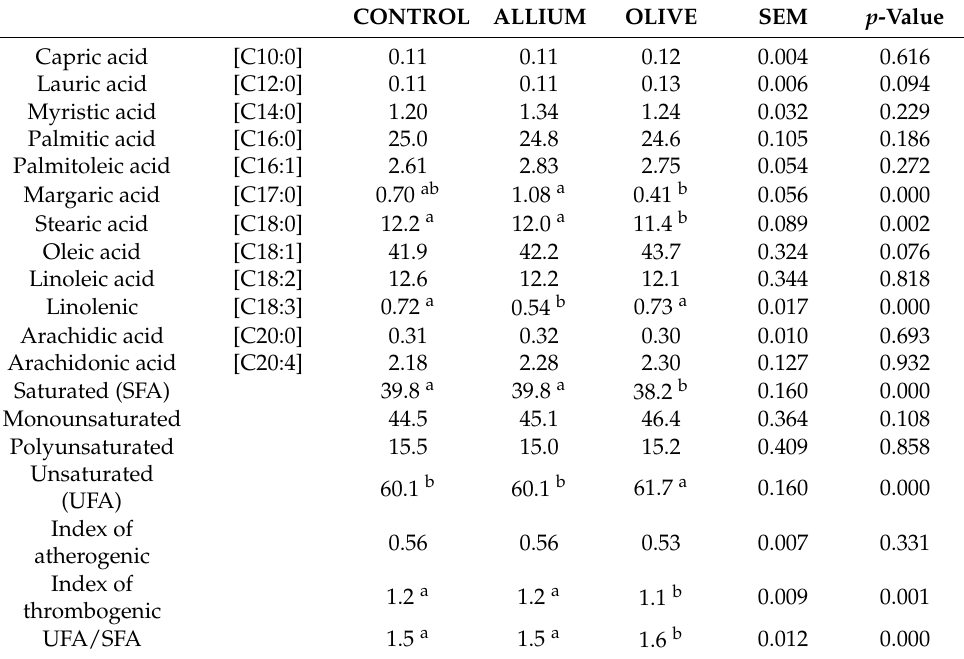
Table 4. Fatty acid composition (%) of intramuscular fat from Longissimus thoracis et lumborum muscles of pigs fed three different